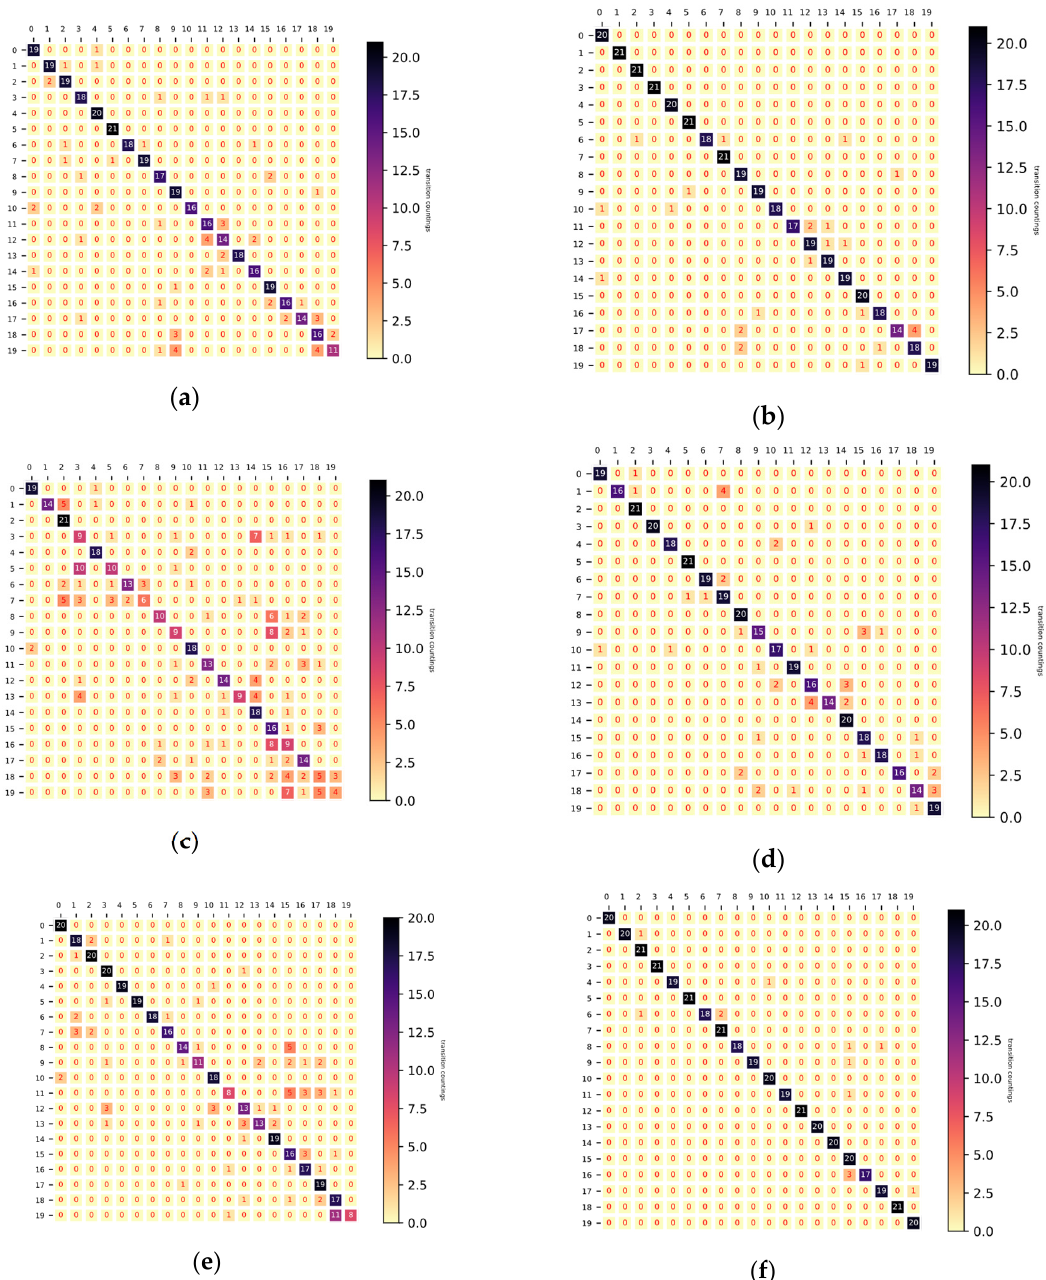
Figure 11. The confusion matrixes of the diagnosis results in SEU_B dataset. ( a ) Confusion matrix for AE, ( b ) confusion matrix for DAE, ( c ) confusion matrix for CNN, ( d ) confusion matrix for AlexNet, ( e ) confusion matrix for LSTM, ( f ) confusion matrix for proposed method.